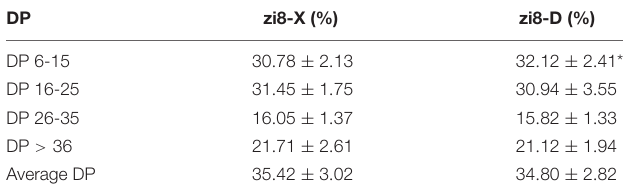
TABLE 4 | Chain length distributions in zi8-X and zi8-D (mean ± SE).